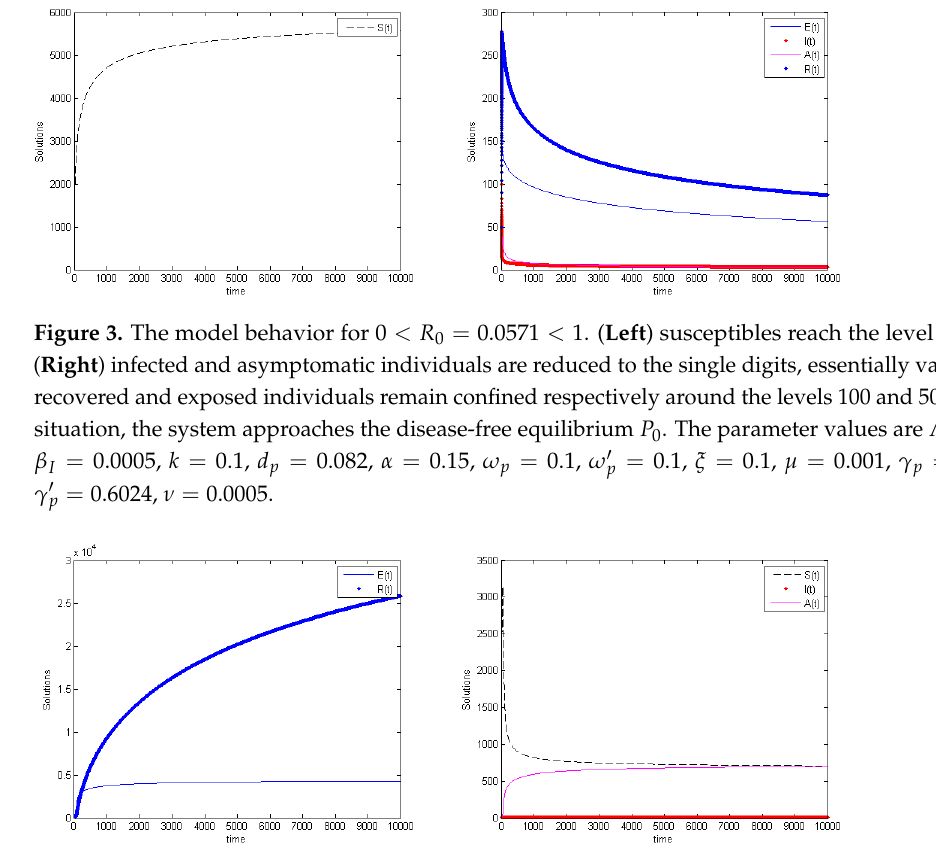
Figure 4. The model behavior for R 0 = 1.2677 > 1. ( Left ) recovered attain the level of 25,000, exposed instead about 4000; ( Right ) infected stabilize at around the 200 level, susceptibles and asymptomatic individuals remain confined around the level 100. Once again the system settles at the endemic equilibrium, but this time we have ξ = 0 and α = 1, so that the point attained is P I . The parameter values are Λ = 500, β I = 0.01, k = 0.1, d p = 0.0082, α = 1, ω p = 0.1, ω (cid:48) p = 0.1, ξ = 0, µ = 0.001, γ p = 1.764, γ (cid:48) p = 0.6024, ν =